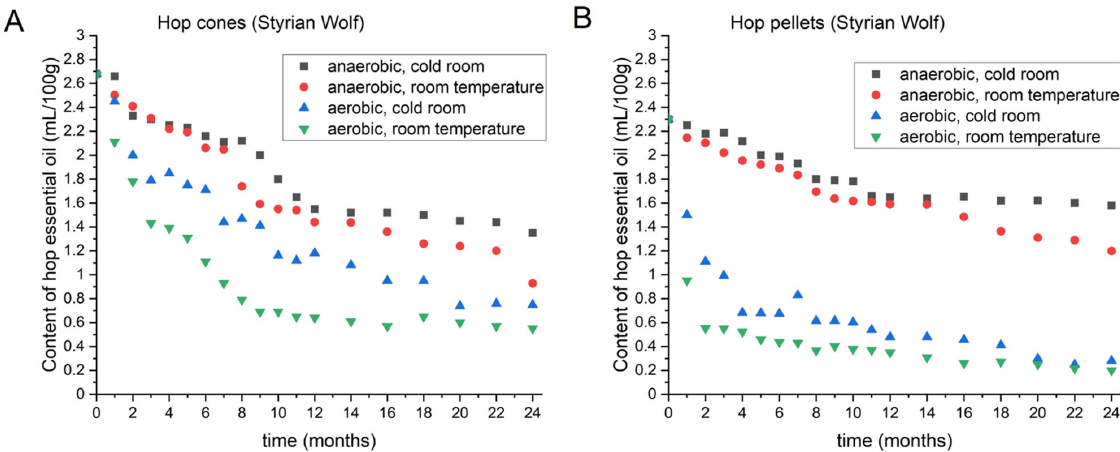
Figure 3. Changes in the content of hop essential oil in Styrian Wolf cones ( A ) and pellets ( B ) during two ‐ year period, under different storage conditions.